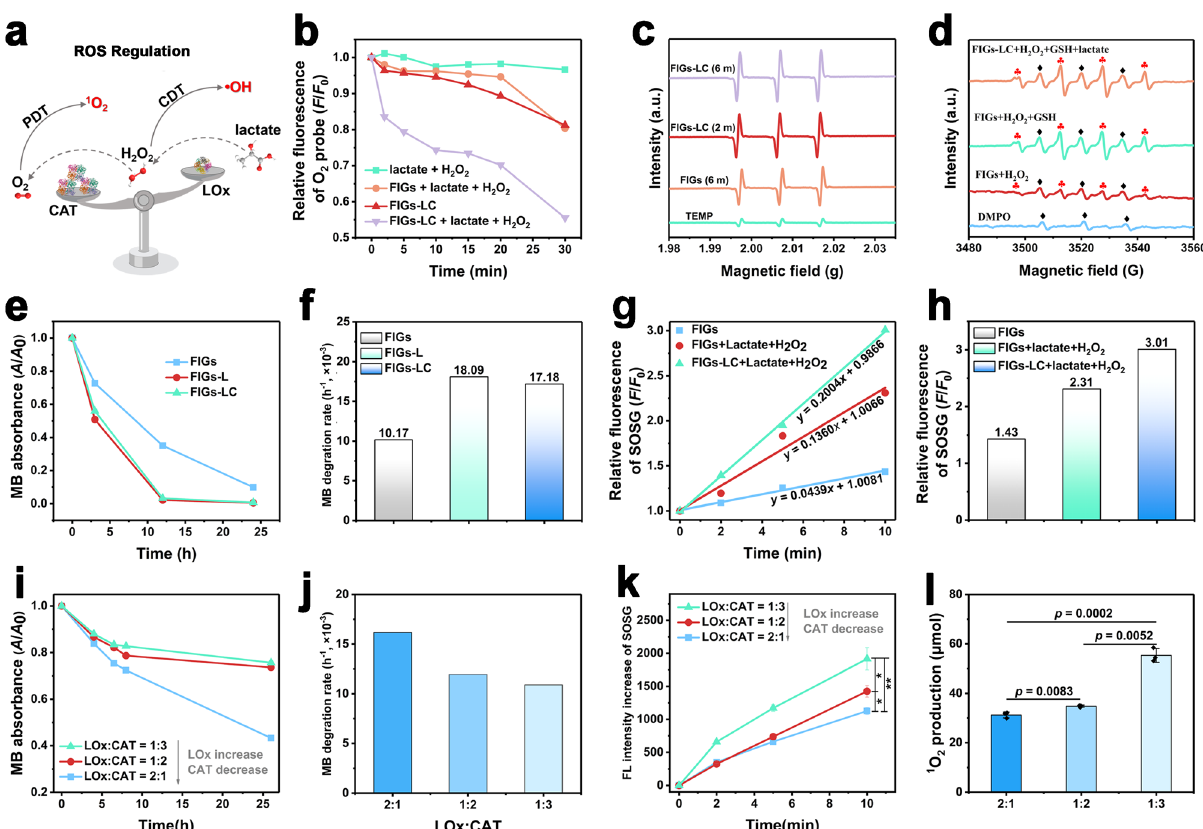
Fig. 4 ROS regulation by FIGs-LC. a Schematic ROS regulation of LOx-modulated ·OH and CAT-modulated 1 O 2 production. b Changes ( F / F 0 ) in the fl uorescence intensity of O 1 O 2 probe (Ru(dpp)) over time. c ESR spectra of 2 with TEMP as trapper. d ESR spectra of ·OH with DMPO as trapper, red clubs: hydroxyl free radicals; black diamonds: oxidized DMPO radicals. e Degradation ( A / A 0 ) of methylene blue (MB) over FIGs, FIGs-L, and FIGs-LC in the simulated TME solutions with pH 6.0 (100 μ M of H 2 O 2 , 10 mM of GSH, and 2 mM of lactate). f Relative degradation rates of MB according to the iron concentration. g Relative fl uorescence intensity of SOSG as a function of laser irradiation time for the FIGs and FIGs-LC. h Fluorescence intensity of SOSG at 10 min for the FIGs and FIGs-LC. i The MB degradation curve of FIGs-LC with the different loading amount of LOx and CAT (1:3, 1:2, 2:1, LOx:CAT, U/U) under the simulated tumor microenvironment. j MB degradation rates of FIGs-LC with different loading ratios between LOx and CAT, and each histogram represents the mean ± s.d. k The fl uorescence changes of 1 O 2 probe (SOSG) of FIGs-LC with different loading amounts of LOx and CAT (1:3, 1:2, 2:1, LOx:CAT, U/U) under the simulated tumor microenvironment. l The 1 O 2 production of FIGs-LC with different loading ratios between LOx and CAT at 5 min. In k and l , data are presented as mean ± s.d. from three independent replicates; p values were analyzed by Student ’ s two-sided t